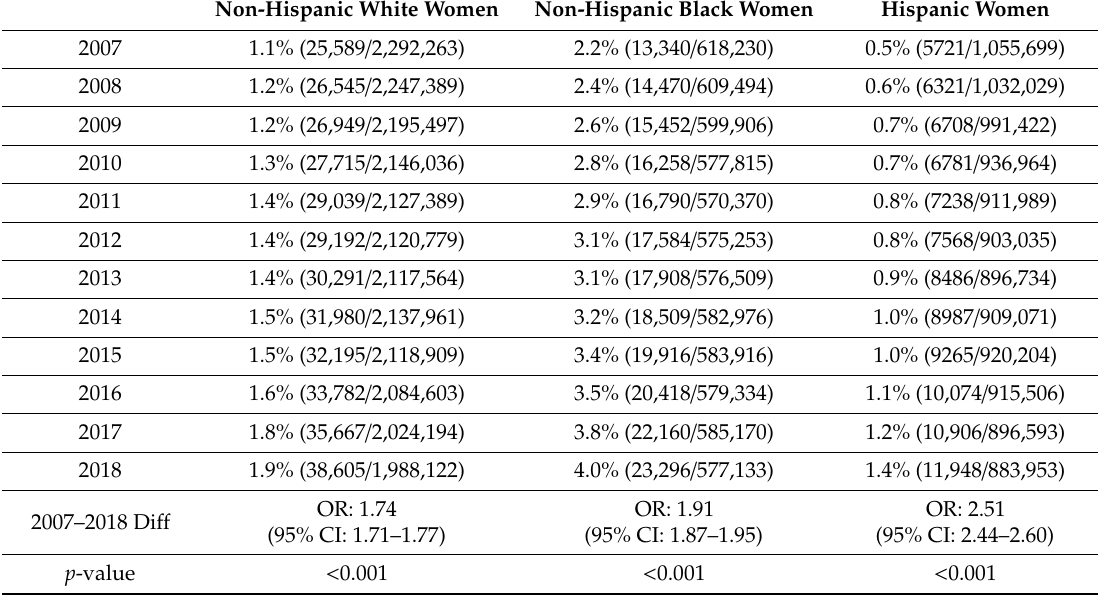
Table 2. Annual prevalence of chronic hypertension (CH) for 2007–2018, by racial / ethnic